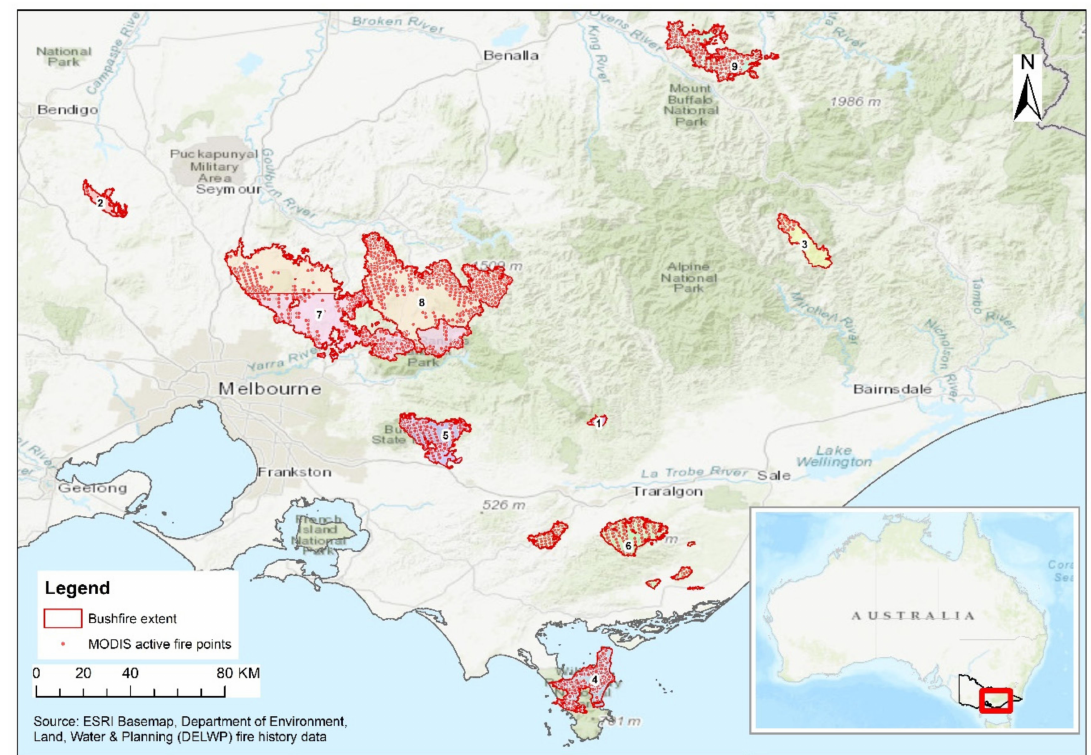
Figure 1. Topographic map of the study area (Victoria) showing bushfire points of 9 different fires used in the analysis. These points are active bushfire points recorded by Moderate Resolution Imaging Spectroradiometer (MODIS)